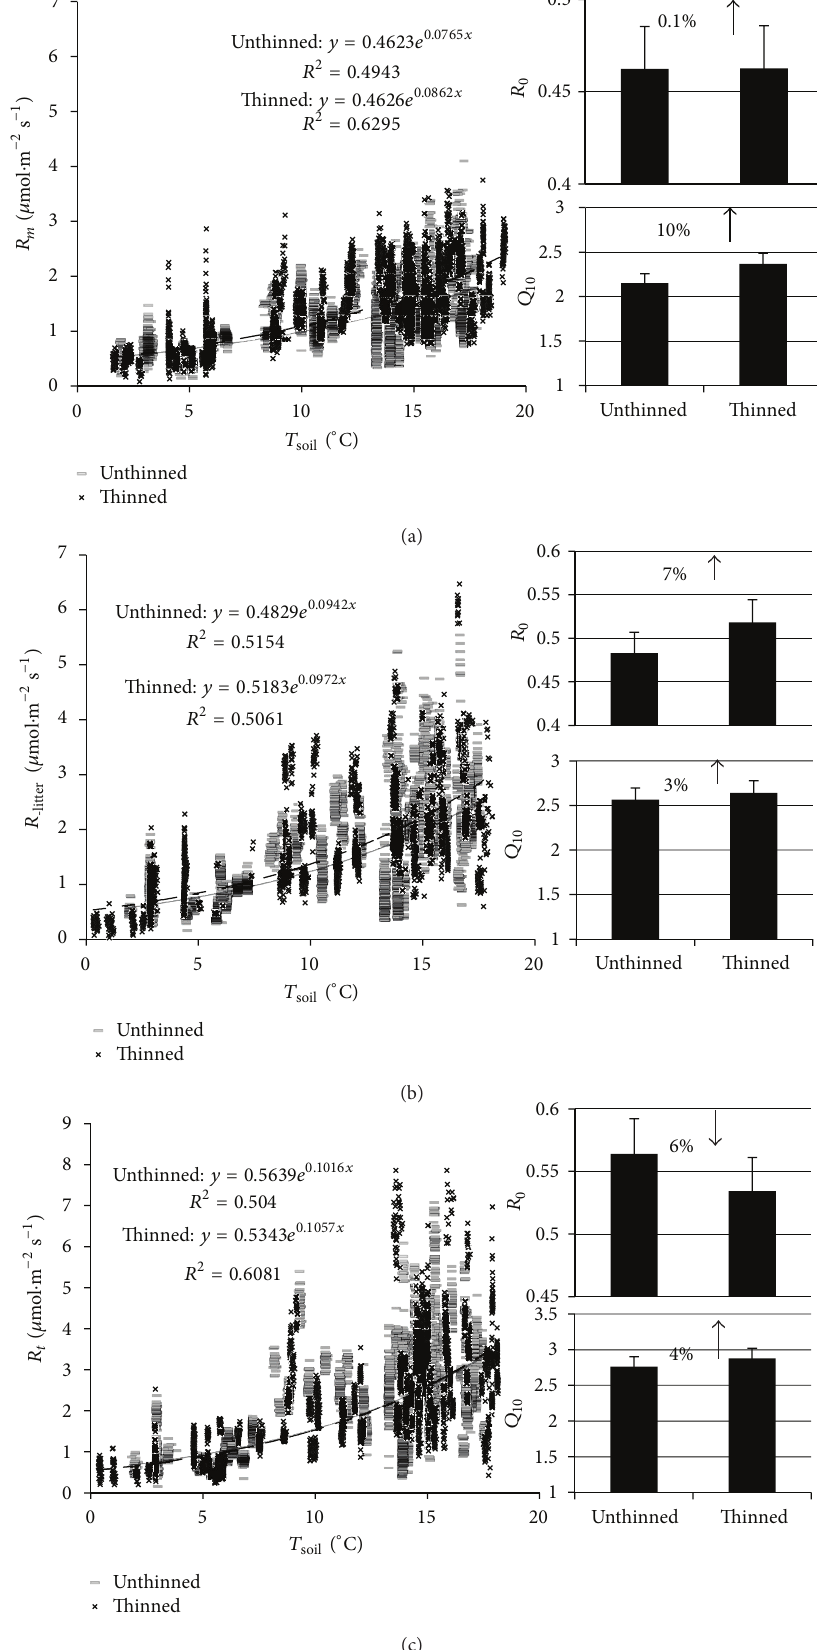
, and 𝑅 𝑡 between the unthinned and thinned sites from 2005 to litter